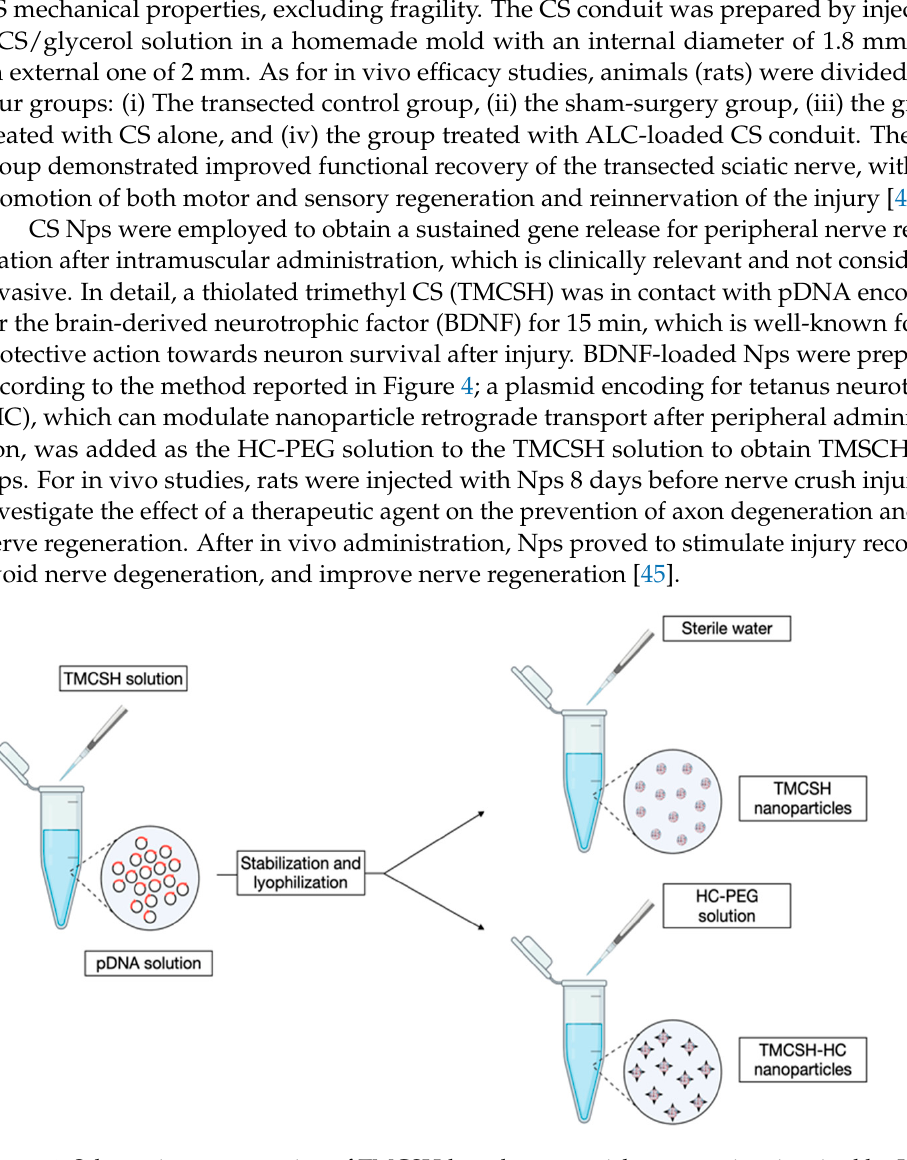
Figure 4. Schematic representation of TMCSH-based nanoparticle preparation, inspired by Lopes and collaborators [45].